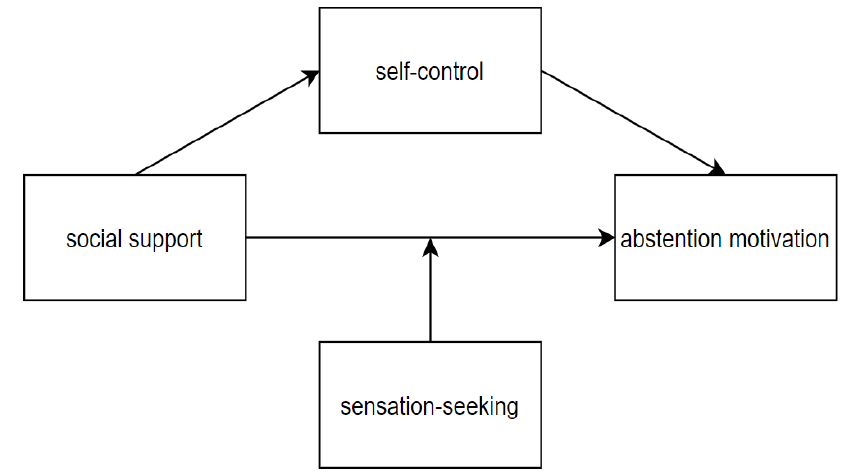
Figure 1. Th e proposed